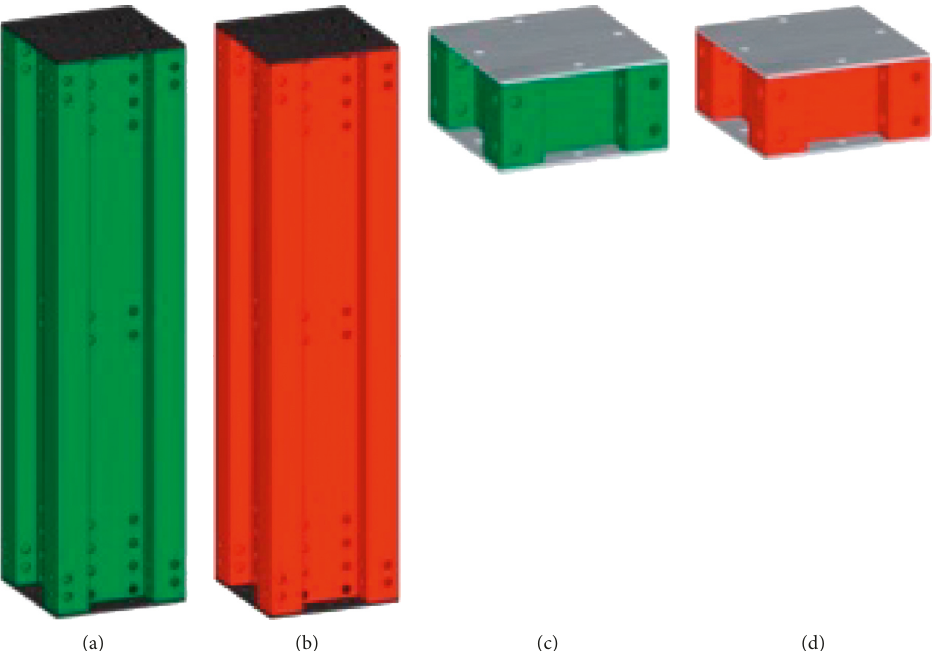
Figure 7: Basic units, BU1 and BU2, with different colours depending on their thickness. BU1: (a) t � 2 mm (green colour) and (b) t � 3mm (red colour); BU2: (c) t � 2mm (green colour) and (d) t � 3 mm (red colour).